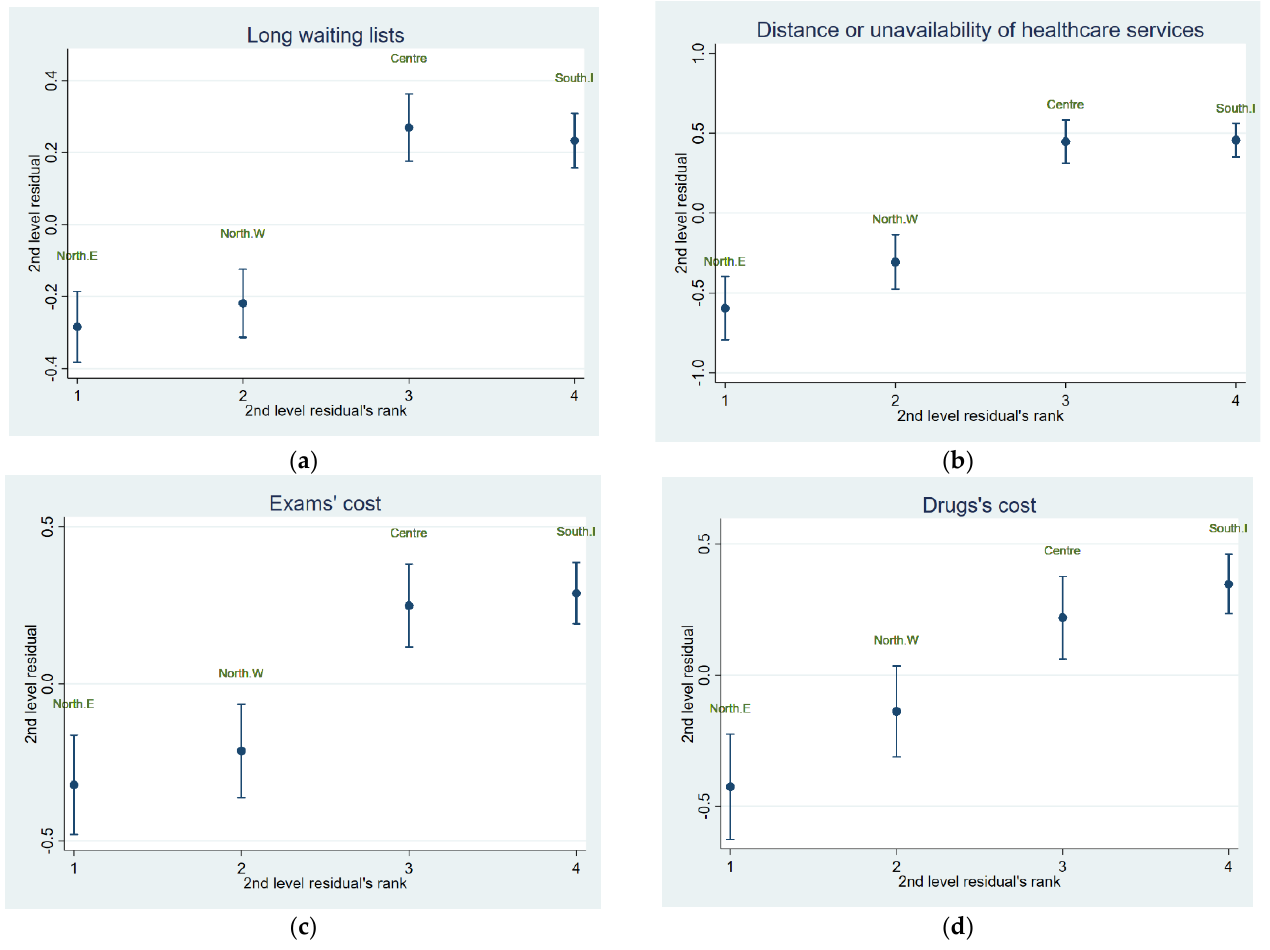
Figure 1. Second level residuals of the variance components of logistic regression models for the delayed utilization due to barriers of ( a ) long waiting list, ( b ) distance or unavailability of means of transport, ( c ) expensive exams, ( d ) expensive prescribed drugs. Legend: North.W = North–West Italy, North.E = North–East Italy, South.I = South-Islands. Table 2. Delayed utilization due to a long waiting list related to the socio-economic and health char- acteristics of respondents: Univariable and multivariable analyses.